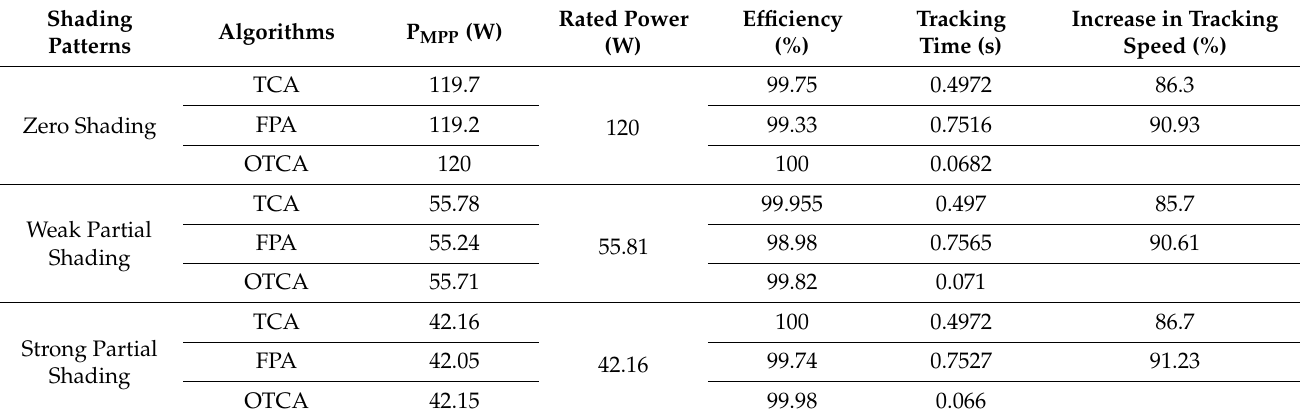
Figure 11. Authentication of OTCA under continuously changing weather conditions. Table 6. Summary of results for the proposed OTCA MPPT algorithm.